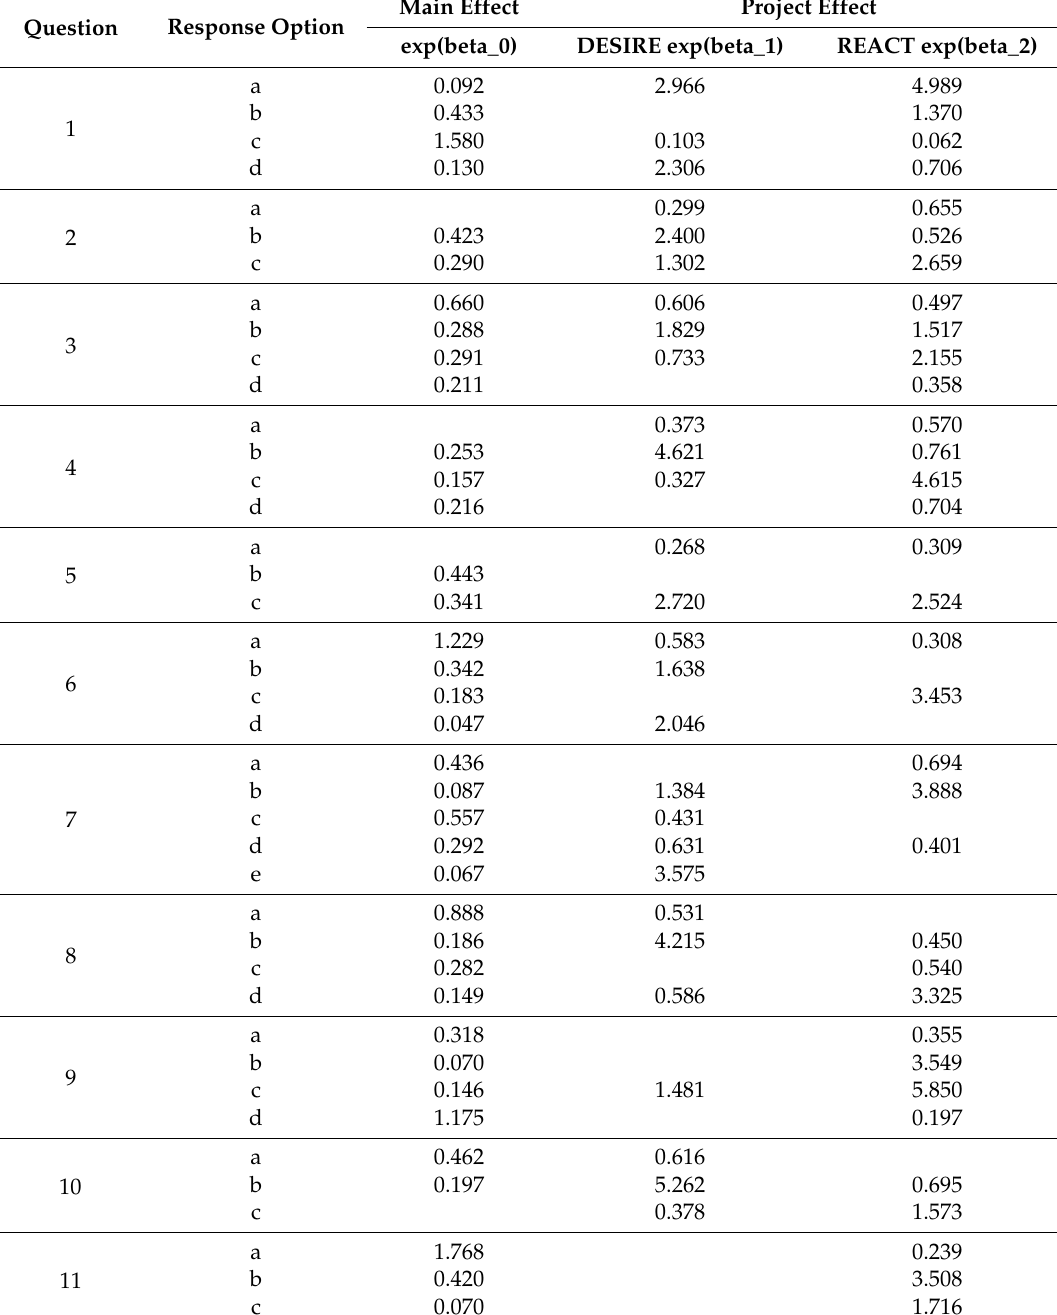
Table 1. Logistic regression: for each question and each response option x, e β 0 indicates the main effect explaining the odds for response option x , e β 1 ; and e β 2 indicates the effect of the DESIRE and REACT projects, respectively, in modifying the odds for response option x